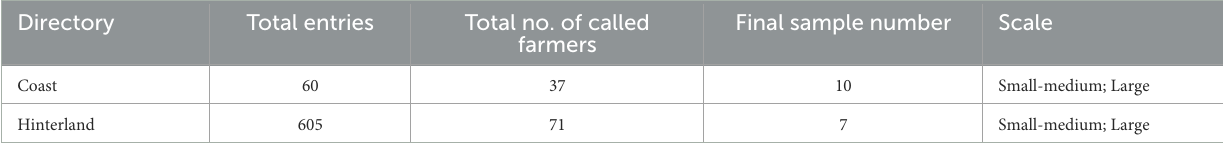
TABLE 3 Final sample frames of coastal and hinterland